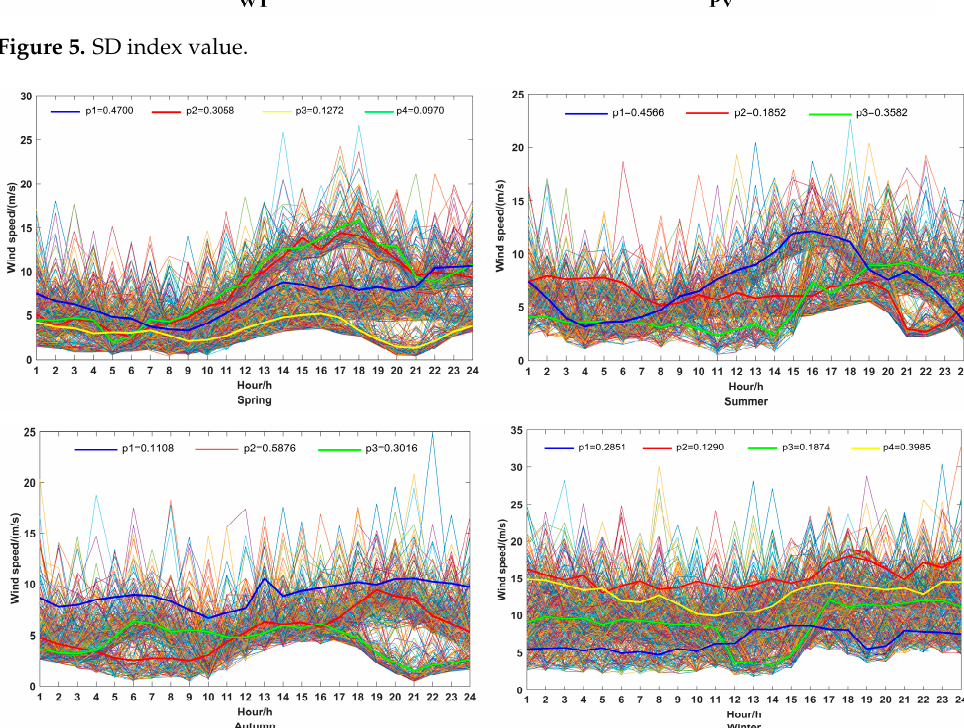
Figure 6. Wind speed (WS) scenario and probability.